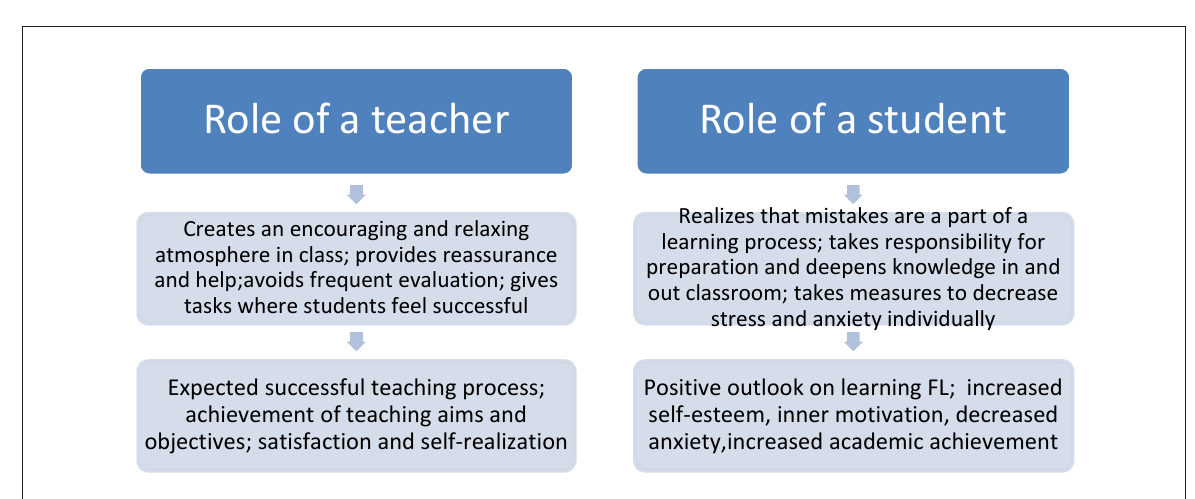
Figure. Strategies for alleviating FLA as recommended by the respondents for successful university learning